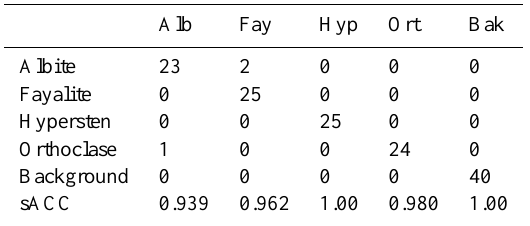
Table 3. Cross validation results for four minerals and background residing on the same substrate SUB-496. Classification accuracy shown at bottom computed from the average of several cross val- idations. Two albite spectra are incorrectly classified as fayalite and one orthoclase spectrum as albite, shown for one particular realiza- tion.